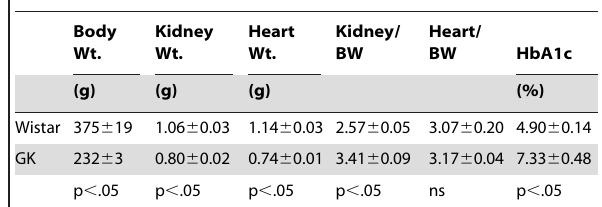
Table 1. Morphometric Data.